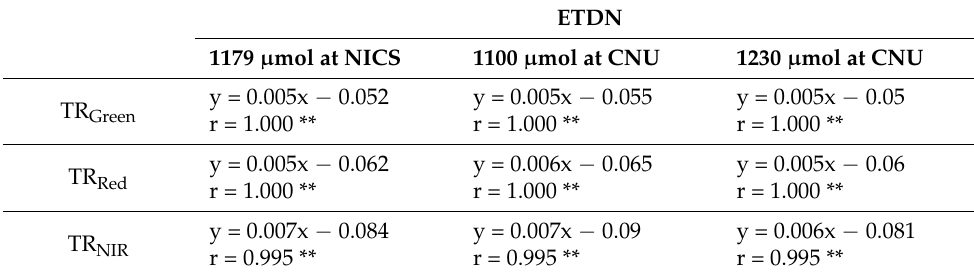
Table 2. Linear regression equations and Pearson’s correlation coefficient (r) of tarp reflectances at the green (TR Green ), red (TR Red ), and NIR (TR NIR ) wavelengths with estimated reflectances at different light intensities of 1179 µ mol at the National Institute of Crop Science (NICS) and 1100 µ mol and 1230 µ mol at Chonnam National University (CNU). ETDN 1179 µ mol at NICS 1100 µ mol at CNU 1230 µ mol at CNU TR